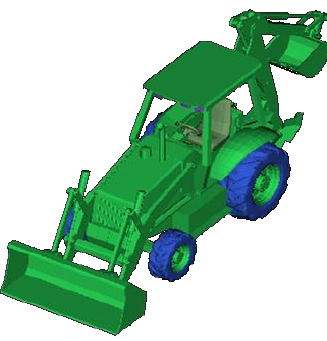
Figure 9. Three-dimensional CAD model of the backhoe.